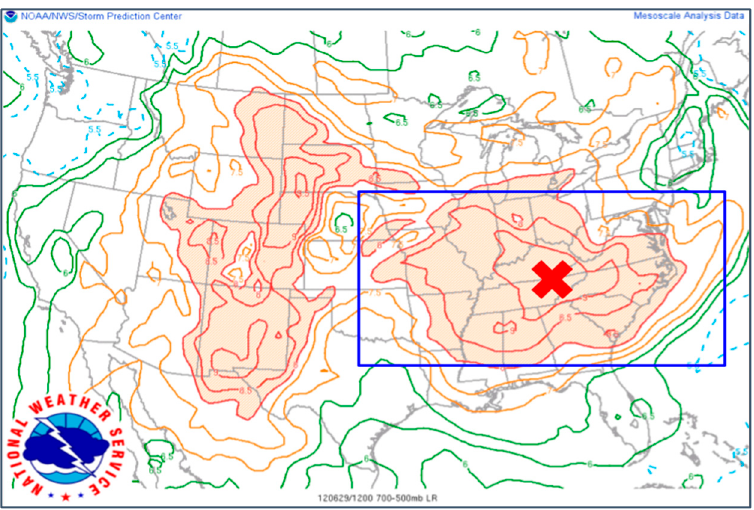
Figure 5. 12Z 29 June 2012 SPC experimental RAP 700–500 hPa analyses of (mid-level) lapse rates ( ◦ C km − 1 ). Blue polygon indicates EML over Midwest and Mid-Atlantic states and red “X” indicates core of anomalously strong